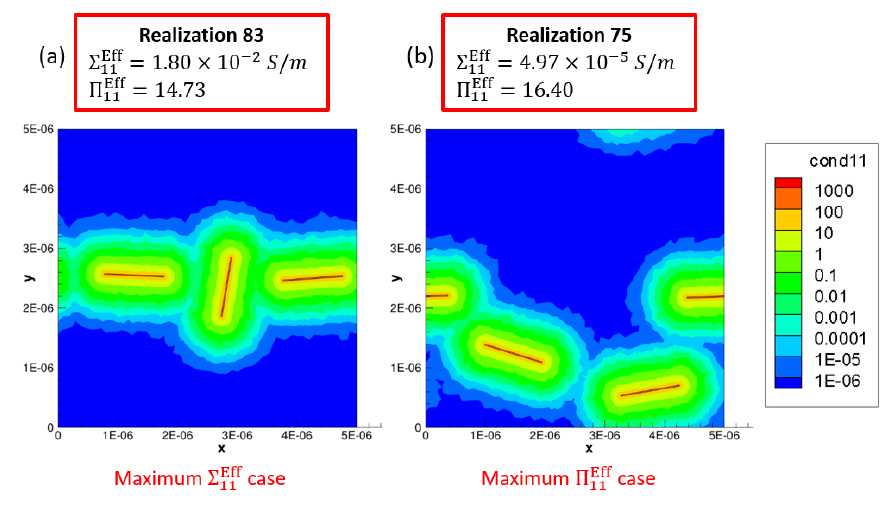
and ( b ) maximum Π Ef f cases at 11 11